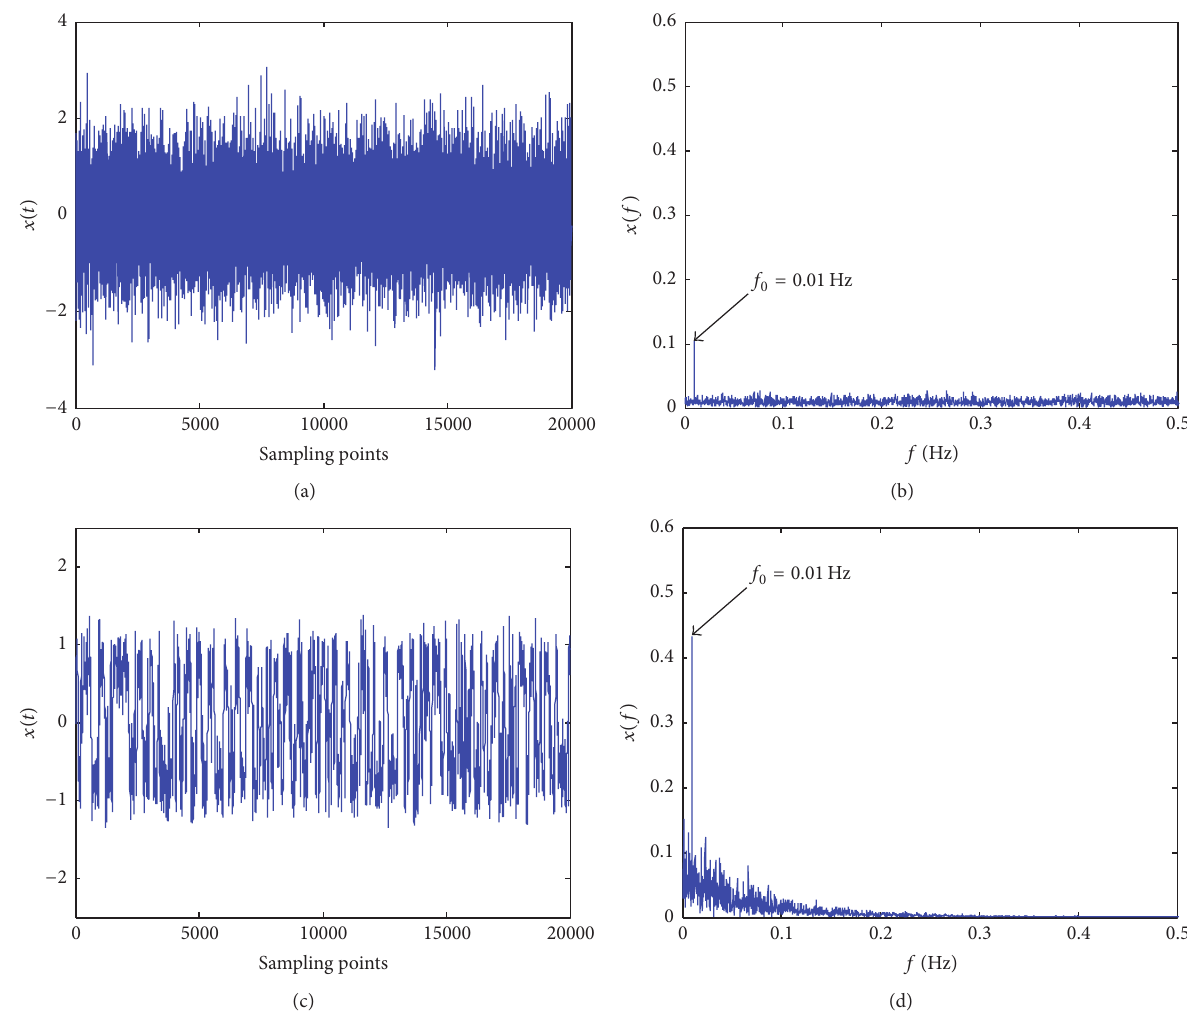
Figure 3: Phenomenon of system SR under the noise intensity 𝐷 = 0.5 . (a) Time-domain waveform of input signals, (b) frequency spectrum of input signals, (c) time-domain waveform of output signals, and (d) frequency spectrum of output signals.